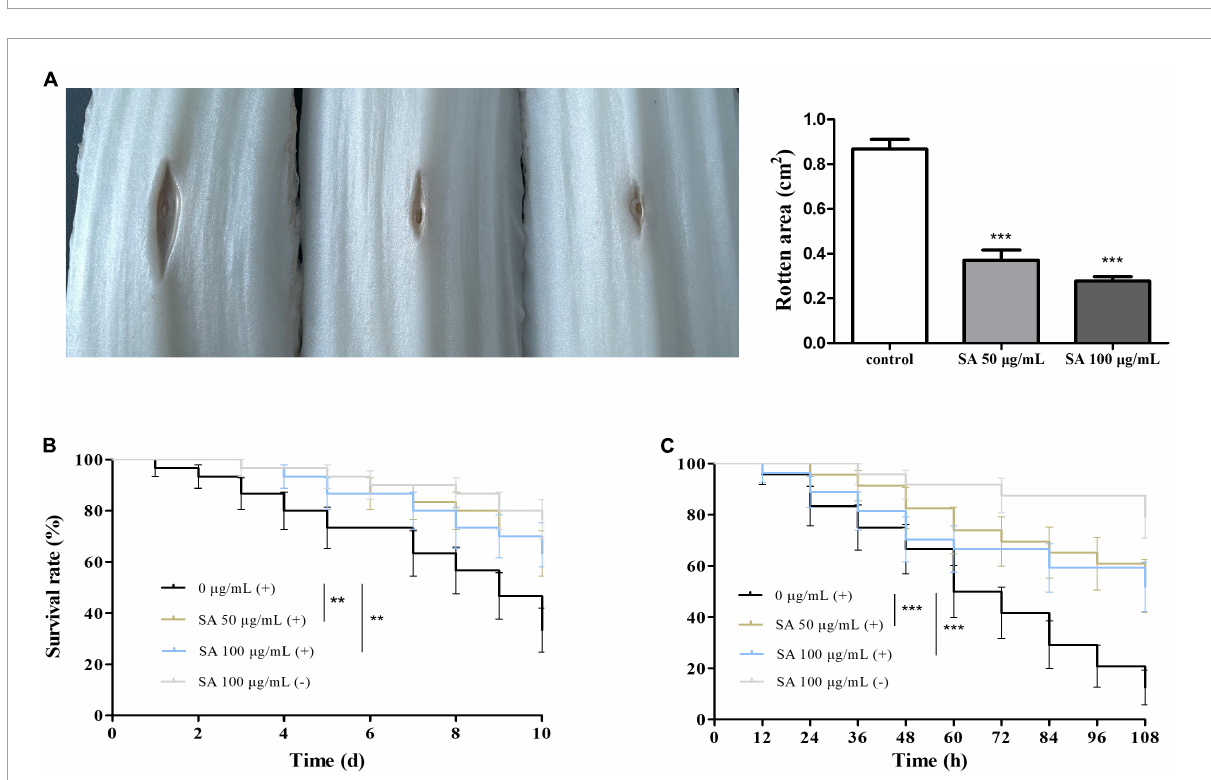
FIGURE7 Effect of SA on the pathogenicity of PAO1. (A) Rotten area of Chinese cabbage; (B) survival rate of fruit flies; and (C) survival rate of nematodes. (+), with PAO1; (–), without PAO1. All data were expressed as mean ± SD values with three independent experiments performed in triplicate. ** p < 0.01; *** p <